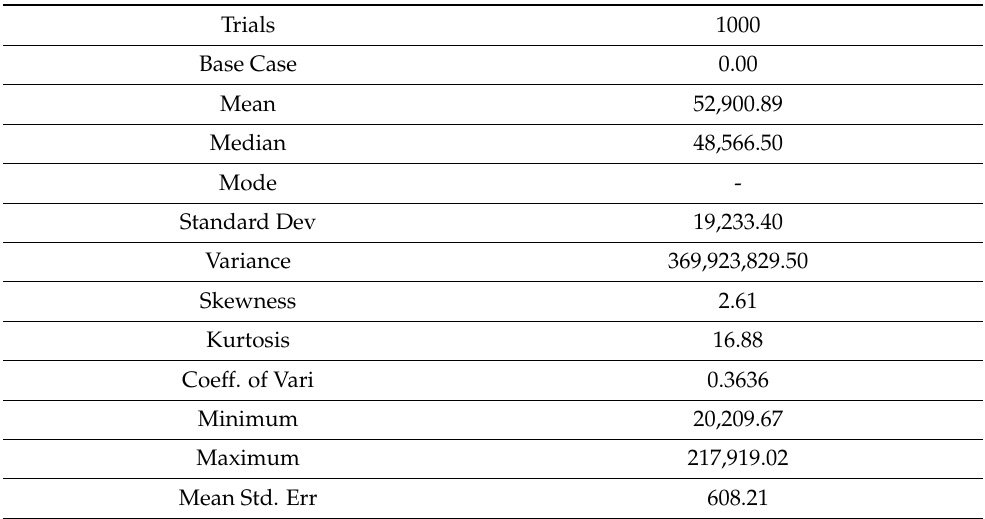
Table 9. Descriptive statistics of the present value distribution for the future incomes from accommo- dation rental facilities for 10 years in Bratislava.